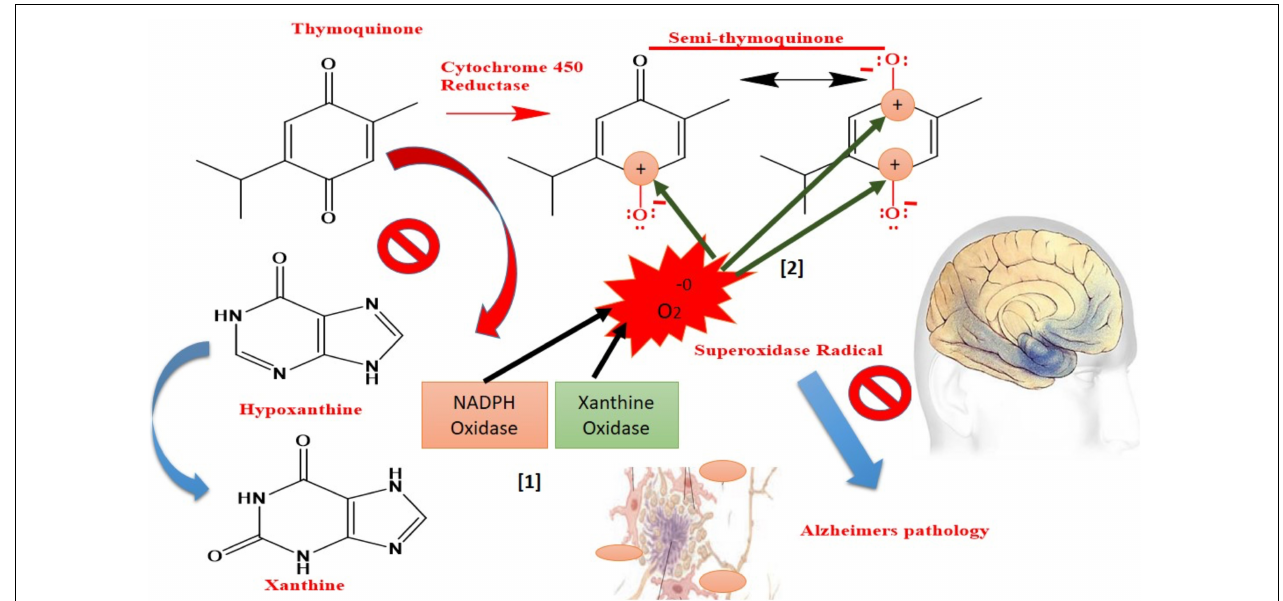
FIGURE 2 | Mechanism of “Thymoquinone” drug toward oxidative stress-mediated AD